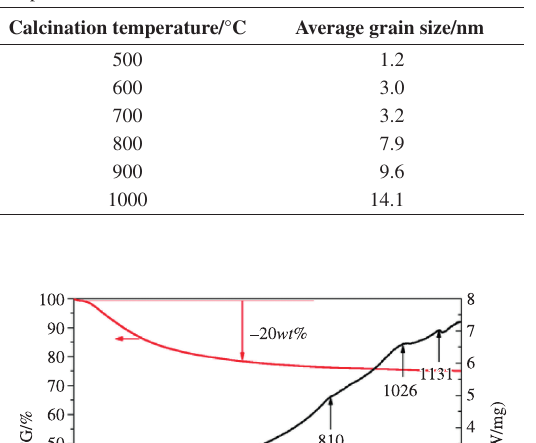
Table 1. The average grain sizes of powders calcined at different temperatures.